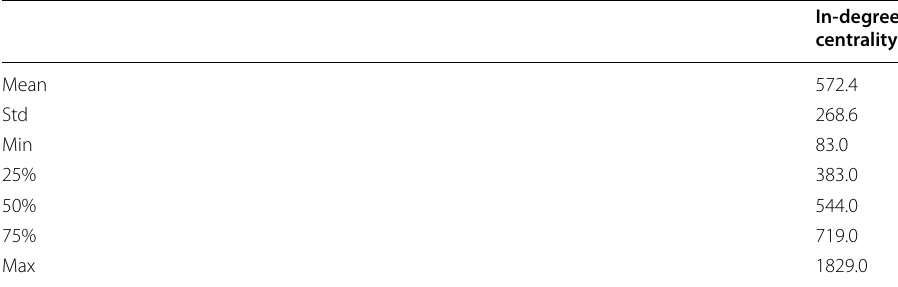
Table 2 Summary statistics of in-degree centrality for hexagon cells in the interpolated mobility